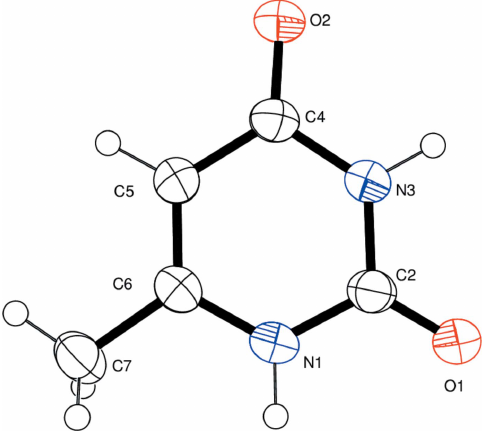
Figure 1 The asymmetric unit of 6Mura in form (II), showing the atom-labelling scheme. Displacements ellipsoids are at the 50% probability level. H atoms are shown as small spheres of arbitrary